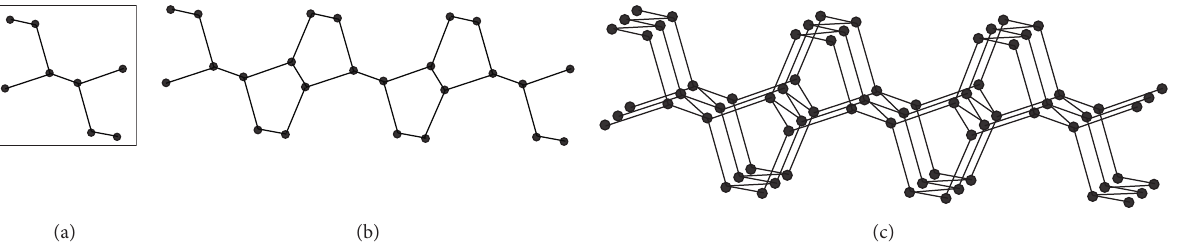
Figure 4: Even layer construction. (a) The unit cell. (b) Chain of three units. (c) The layer of three chains.